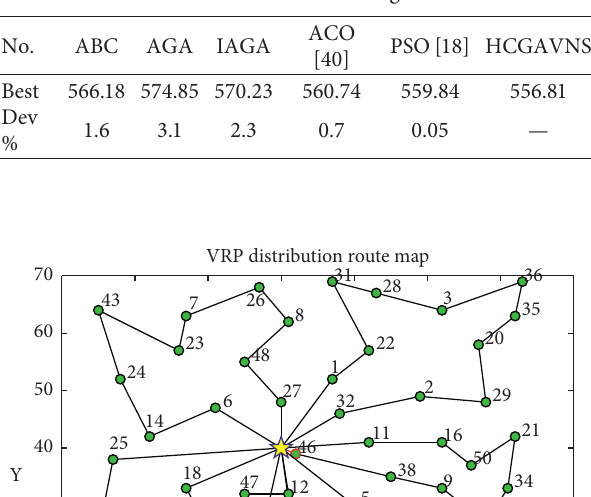
Table 3: Results of various algorithms.